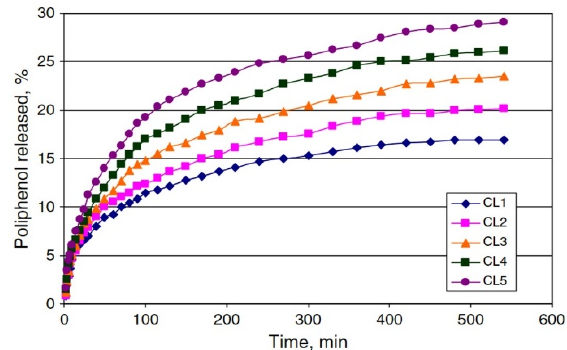
Figure 4. Release profiles of polyphenols from cellulose-lignin (CL) hydrogels in water:ethanol medium, at 37 ◦ C. The lignin contents from CL1 to CL5 are 25%, 33%, 50%, 67%, and 75%, and the average pore sizes are 203 µ m, 215 µ m, 233 µ m, 307 µ m, and 431 µ m, respectively (reproduced from Ref. [24] with permission from Elsevier).